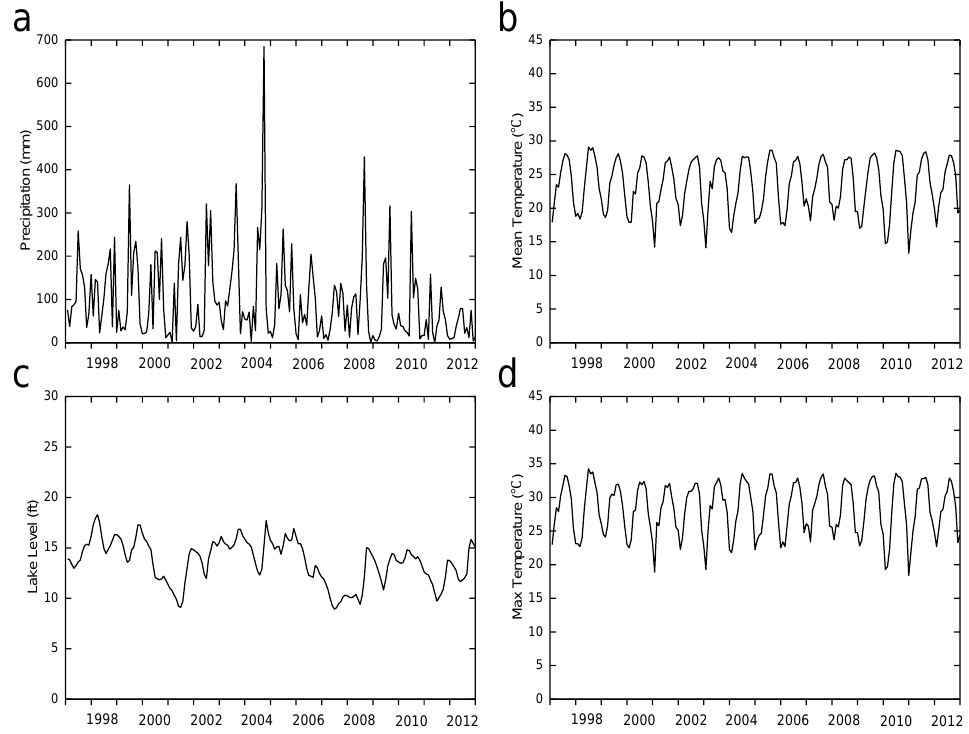
Figure 6. Plots of ( a ) precipitation ( b ) mean temperature ( c ) lake level ( d ) max. temperature.